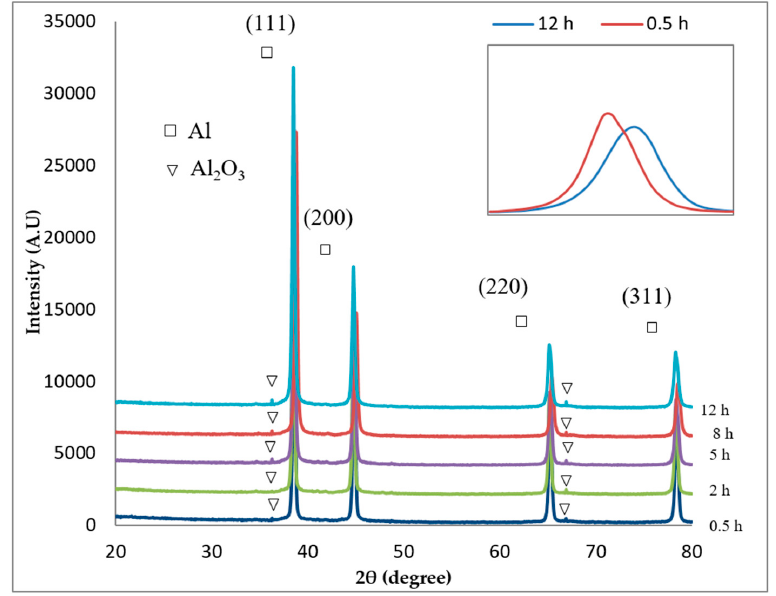
Figure 4. XRD diffraction patterns of Al-5Al 2 O 3 nanocomposite powders milled for different times.